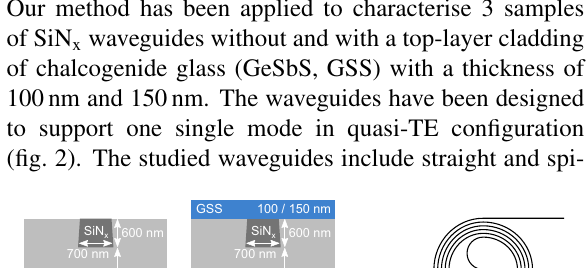
Figure 3. Variation of the ratio between the power in the wings and in the central part of the spectrum with the input power and for three di ff erent coupling e ffi